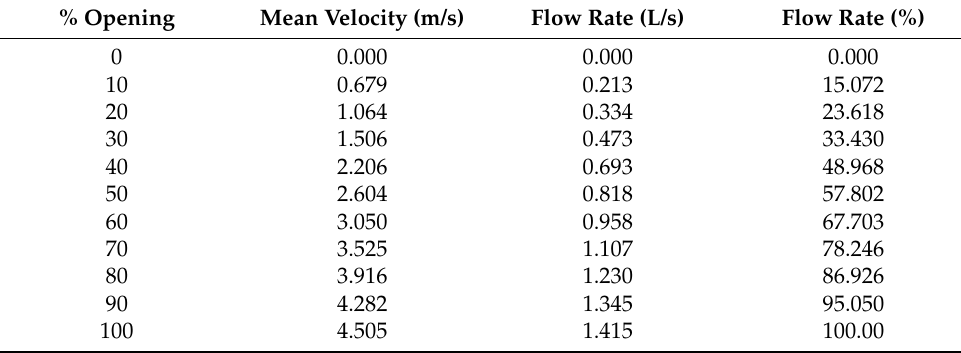
Table 3. Third valve geometry: opening percentage x flow